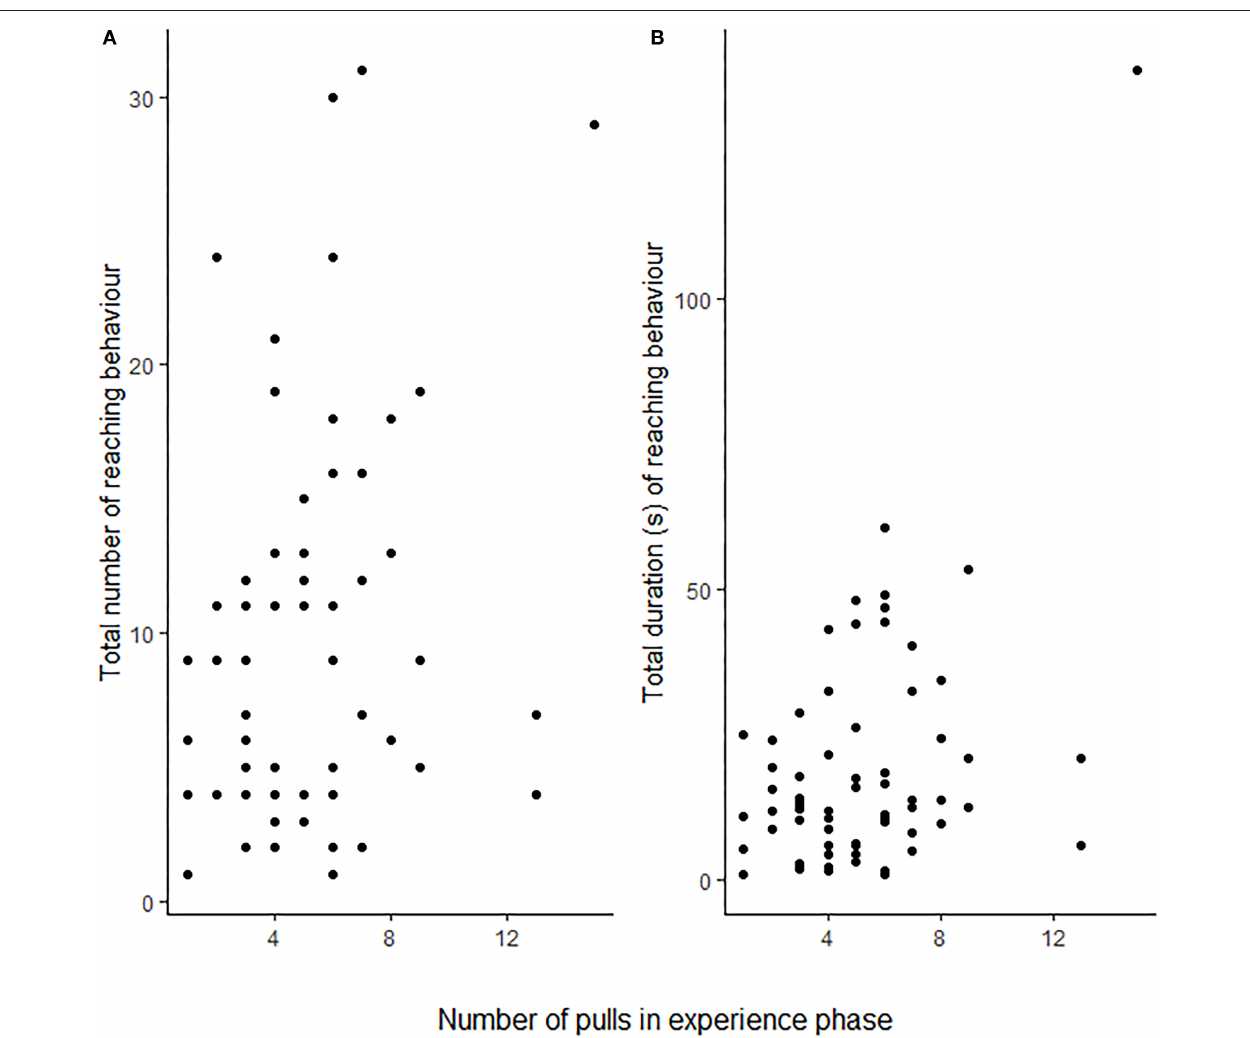
FIGURE 3 | The focal rats’ ( N = 25) total number of reaching events (A) and total amount of time spent reaching (B) in the test phase in relation to the number of food provisionings the same focal animal performed during the test phase. Each point corresponds to a single individual. For statistical results see Table 1